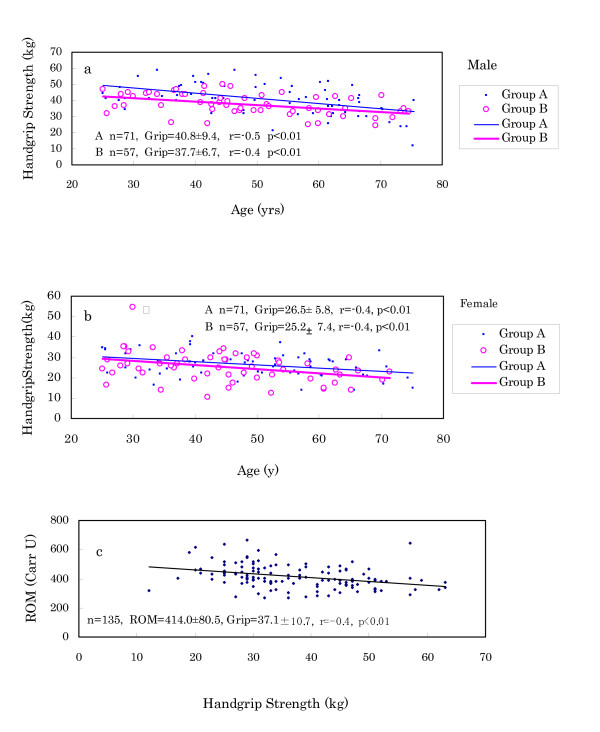
Comparison of handgrip strength between Ulaanbaatar Group A and Group B people (a and b), and correlation of ROM levels with handgrip strength in Murun subjects (c). These findings suggest that ROM production may influence the ageing process.